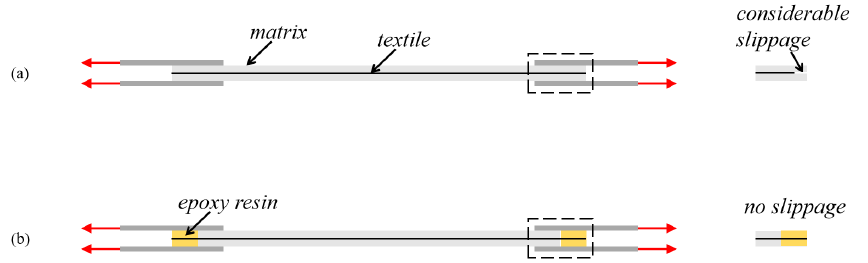
Figure 8. Effect of test setups on force transfer mechanism in TRC composite: ( a ) clevis-grip; ( b ) improved clevis-grip.